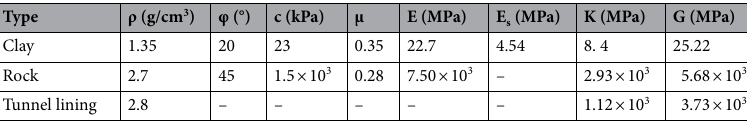
Table 2. Parameter values adopted in this study.